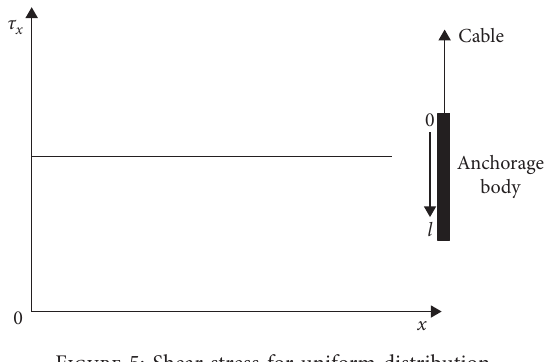
Figure 5: Shear stress for uniform